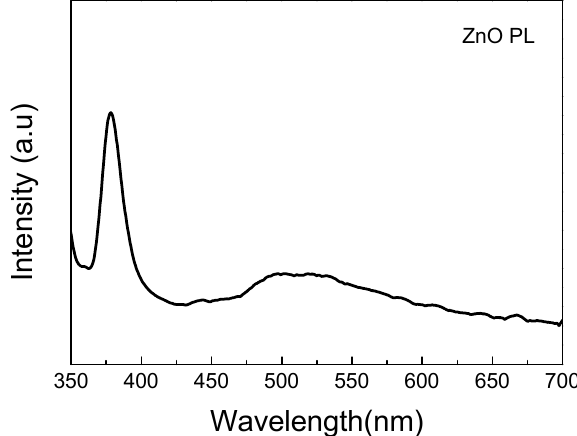
Figure 6. The PL spectrum of zinc oxide nanostructure.